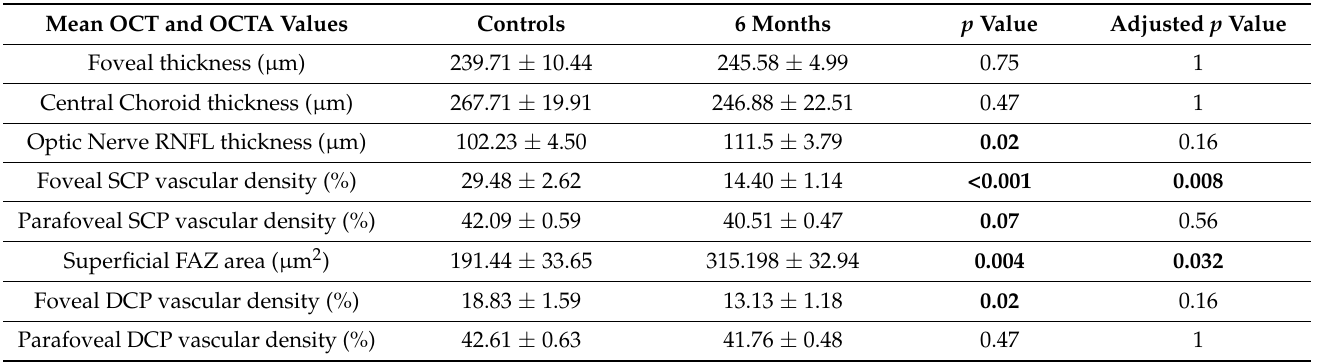
Table 1. Results from the case–control